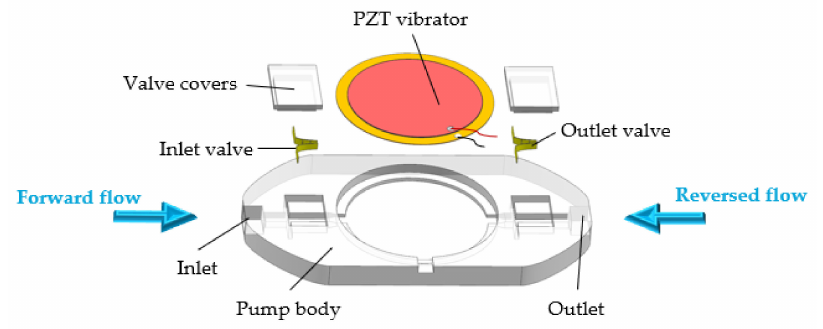
Figure 2. Structure diagram of the piezoelectric pump with flexible valves